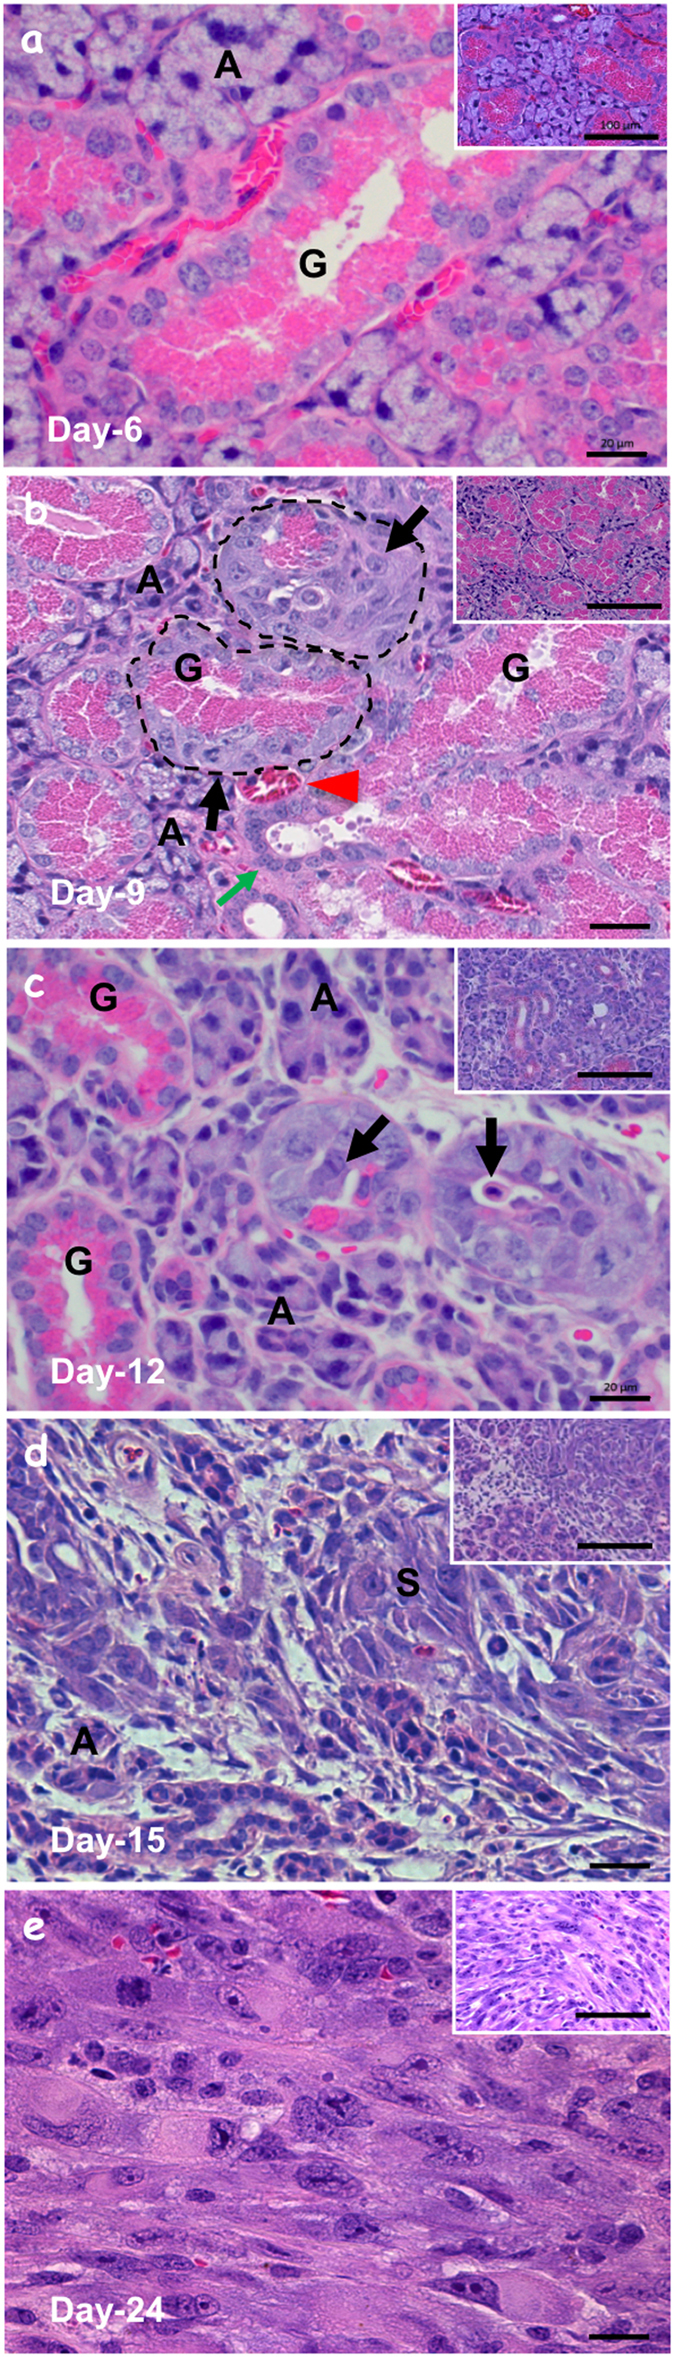
KRASG12V-induced tumors exhibit SDC-like phenotypes.(A–E) H&E staining of submandibular glands harvested from LGL-KRasG12V;Ela-CreERT mice at indicated time points revealed gradual abnormal manifestations starting from day-9 post TAM-feeding. Scale bars: 20 μm and100 μm (inset). G: GCT; A: acini; S: sarcomatous element; SD: striated duct; ED: excretory duct.